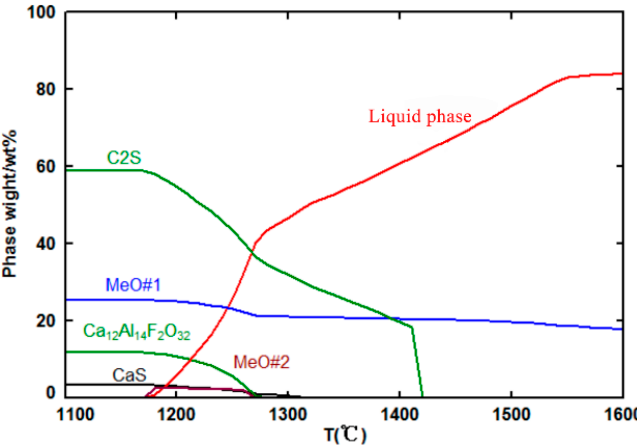
Figure 1. Solidification simulation analysis of synthetic slag S3.